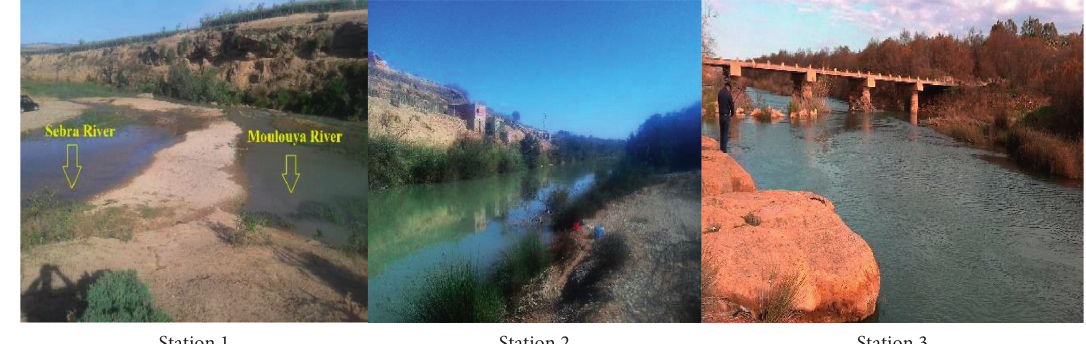
Figure 2: Pictures of different sampling